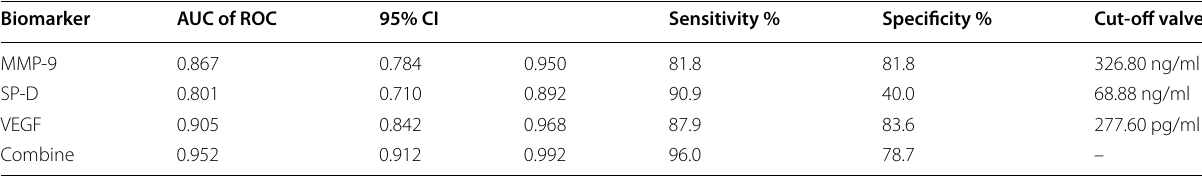
Table 4 ROC curves of the three markers for the independent and combined diagnosis of ILD Biomarker AUC area under the curve, ROC receiver operating characteristic curve, CI confidence interval